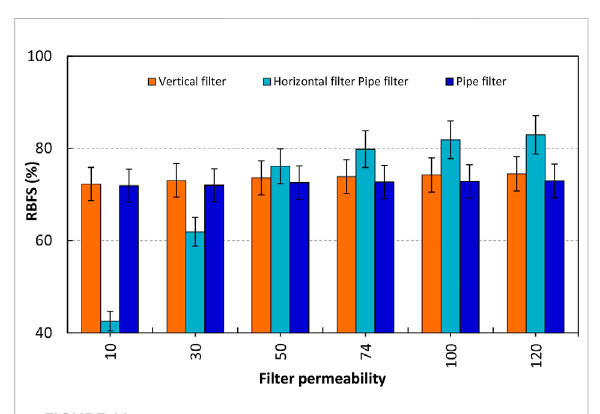
FIGURE 11 Riverbank fi ltration ef fi ciency for fi lter